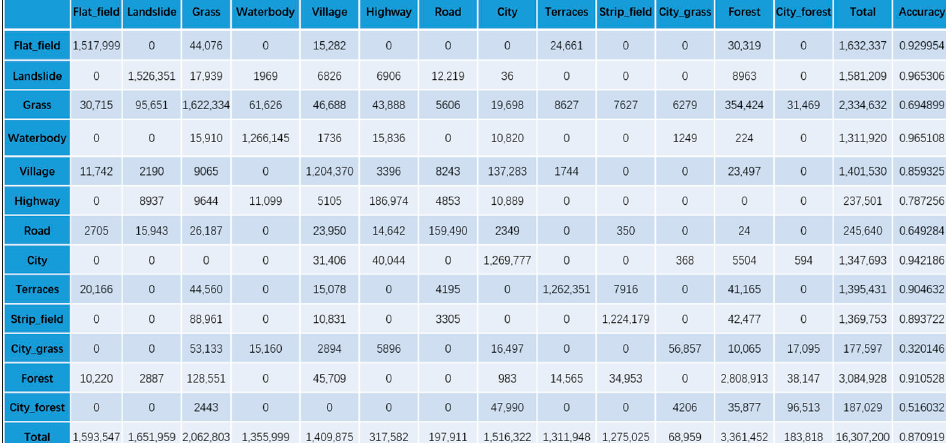
Figure 16. The pixel-based confusion matrix of the U-Net model.